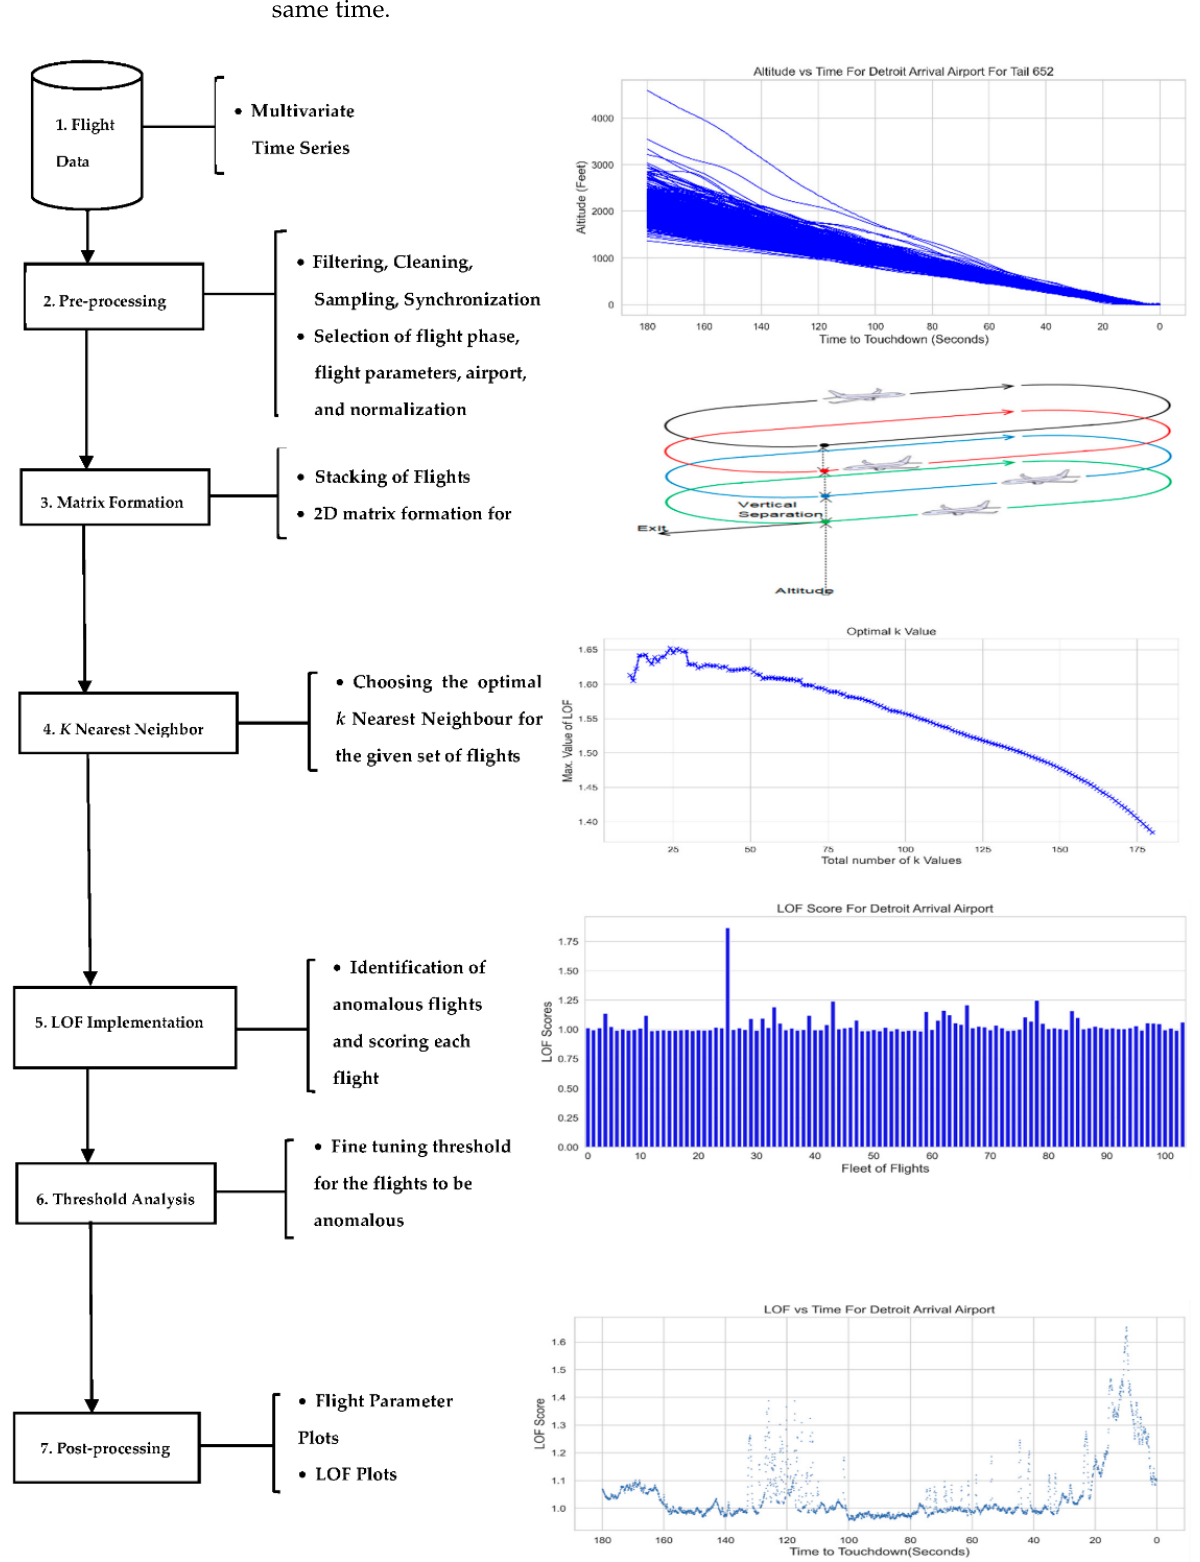
Figure 1. Step-by-step implementation of FDM using hybrid machine learning–statistical method (Image created using BioRender.com).